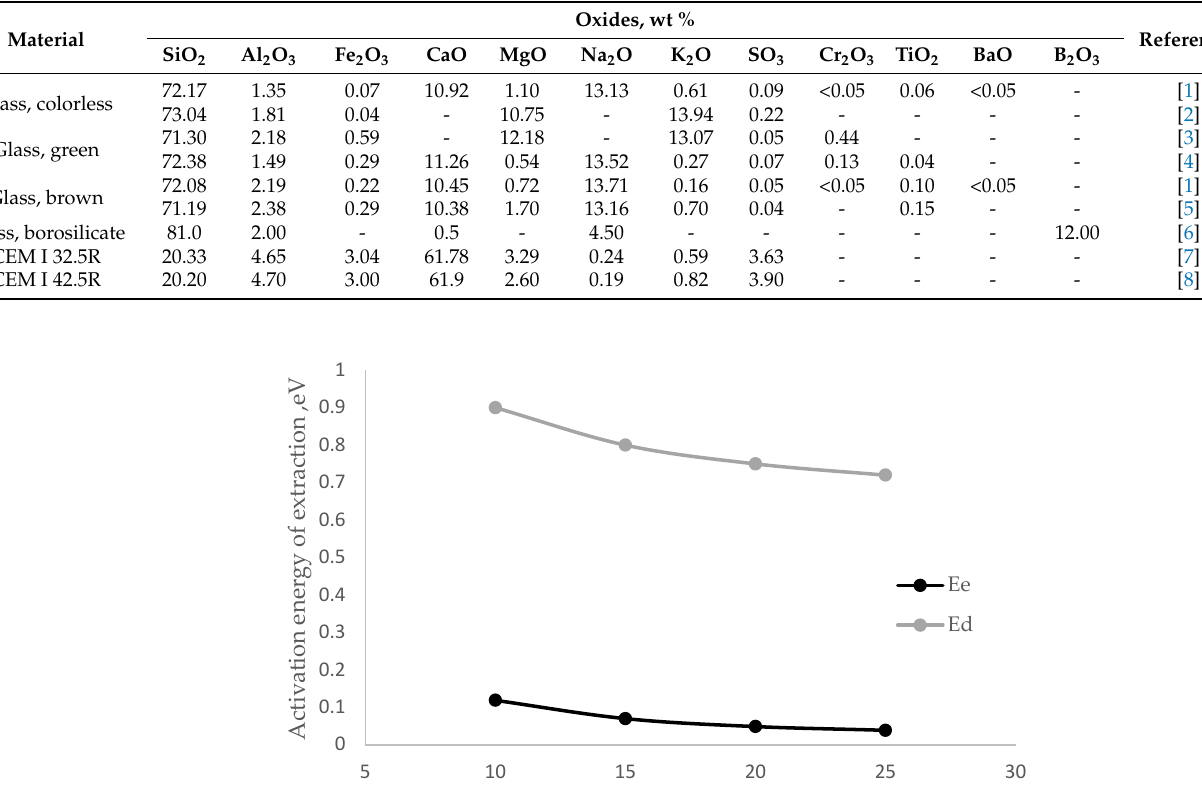
Table 1. Chemical compositions of antagonistic silicate materials.